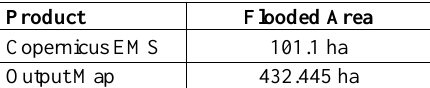
Table 4. The area of inundated areas detected by Copernicus- EMS and this study’s